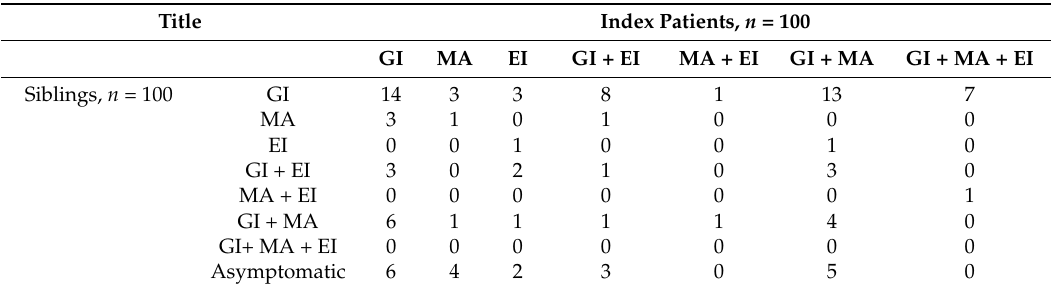
Table 2. Phenotype concordances at celiac disease diagnosis in 100 sibling pairs. Results are presented as numbers of sibling